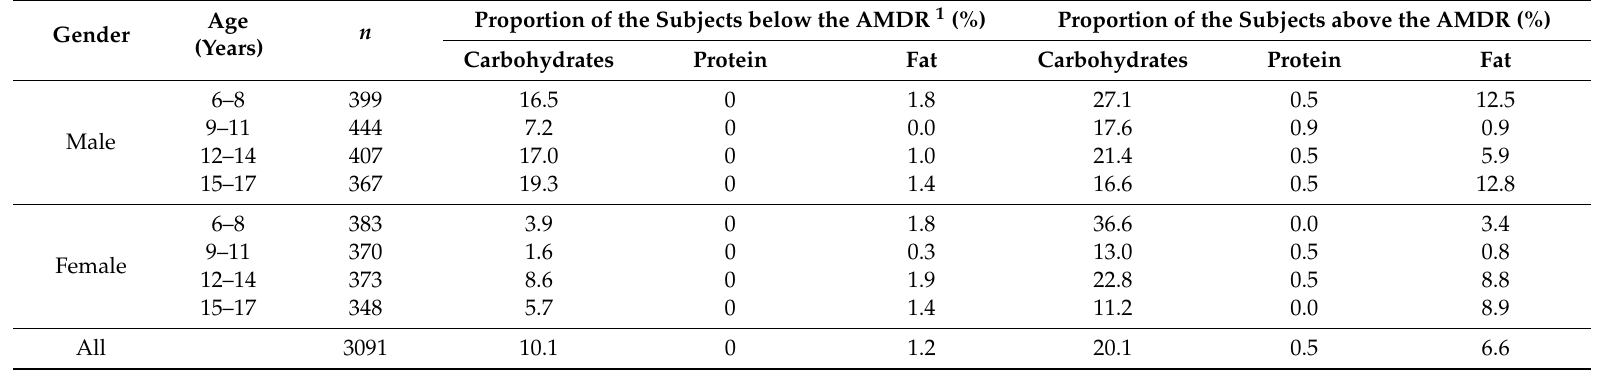
Table 3. The proportion of Korean school-aged children and adolescents with insu ffi cient and excessive intake of the percentages of energy from carbohydrates, protein, and fat.